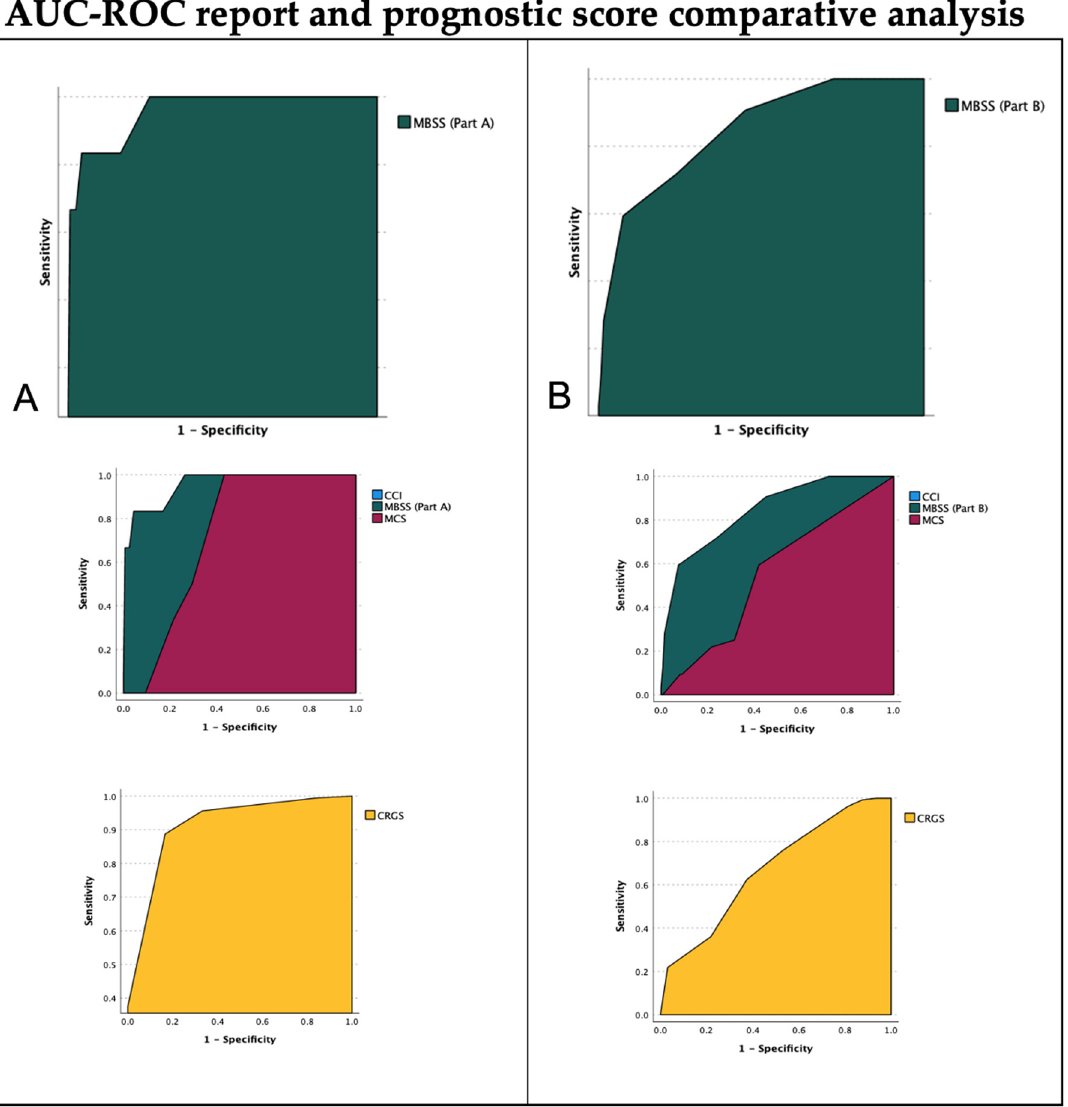
Figure 2. Score AUC-ROC analysis. The area under the curve at the receiver operating characteristic analysis (AUC-ROC) of the MBSS, its sub-scores, and previously validated prognostic scores are shown. ( A ) The AUC of MBSS Part A is reported in the higher part of the figure. In the middle, the AUCs of MCS, CCI (superimposed to MCS and not graphically visualised), and MBSS-Part A are shown for comparison. In the lower image, the AUC-ROC of CRGS is visualised. The AUC-ROC testing variable was a post-operative functional deterioration as defined in the manuscript. MBSS Part A provided the highest AUC in the current analysis. ( B ) The AUC of MBSS Part B is reported in the higher part of the figure. In the middle, the AUCs of MCS, CCI (superimposed to MCS and not graphically visualised), and MBSS-Part B are shown for comparison. In the lower image, AUC-ROC of CRGS is visualised. The AUC-ROC testing variable was a reduction of KPS at follow-up of at least 20 points compared with baseline, plus a quality of life assessment under the 75th percentile. MBSS Part B provided the highest AUC in the current analysis. MBSS: Milan biometric surgical score; CCI: Charlson comorbidity index; MCS: Milan complexity scale; CRGS: clinical–radiological grading system.